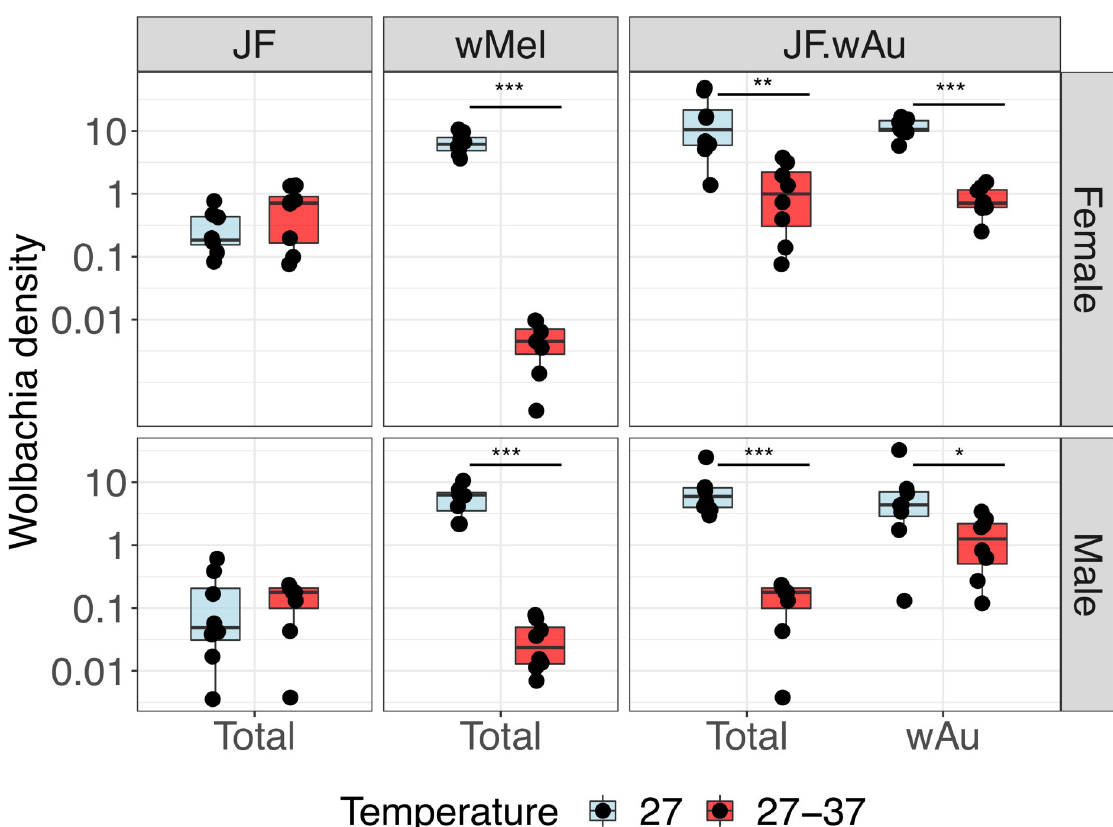
Fig 3. Exposure to high larval breeding temperatures. Larvae from w Mel- Ae . albopictus , JF. w Au and JF lines were reared with a diurnal cycle of 27–37˚C. Controls were maintained at constant 27˚C. Boxplots represent 8 biological replicates: the centre indicates the median of densities and whiskers represent upper and lower extremes. T-test and Mann-Whitney test were used for statistical analyses. � p < 0.05, �� p < 0.001, ��� p < 00001. Non-significant differences are not